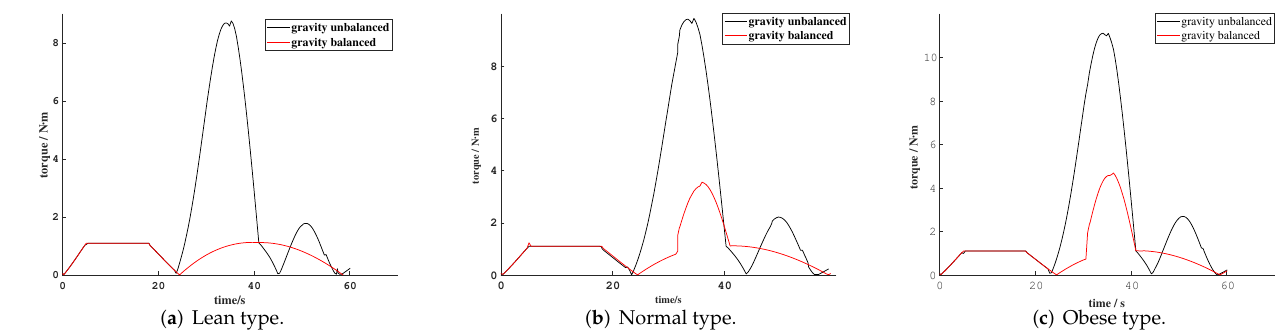
Figure 9. Motor torque variations during knee rehabilitation training with 3 different weights.